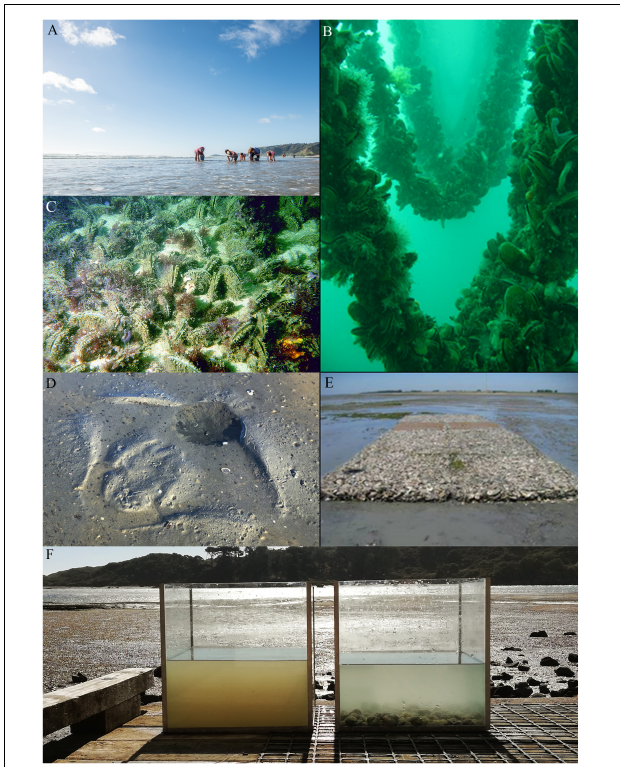
FIGURE 1 | Examples of ecosystem services provided by shellfish. (A) Recreational gathering of shellfish for food in New Zealand (Chris Williams, NZ Story), (B) mussel ( Perna canaliculas ) aquaculture (Chris Woods), (C) habitat provision by horse mussel ( Atrina zelandica ) beds (Simon Thrush), (D) infaunal shellfish ( Austrovenus stutchburyi , Macomona liliana ) as a food source for stingrays on the intertidal sandflat (Helen Cadwallader), (E) sediment and shoreline stabilization by artificial oyster ( Crassostrea gigas ) reefs (NIOZ, EcoShape), and (F) water clarity improvements and contaminant removal through filter feeding, comparing aquaria with (right) and without (left) shellfish ( A. stutchburyi ) (Vera Rullens). Images reproduced with